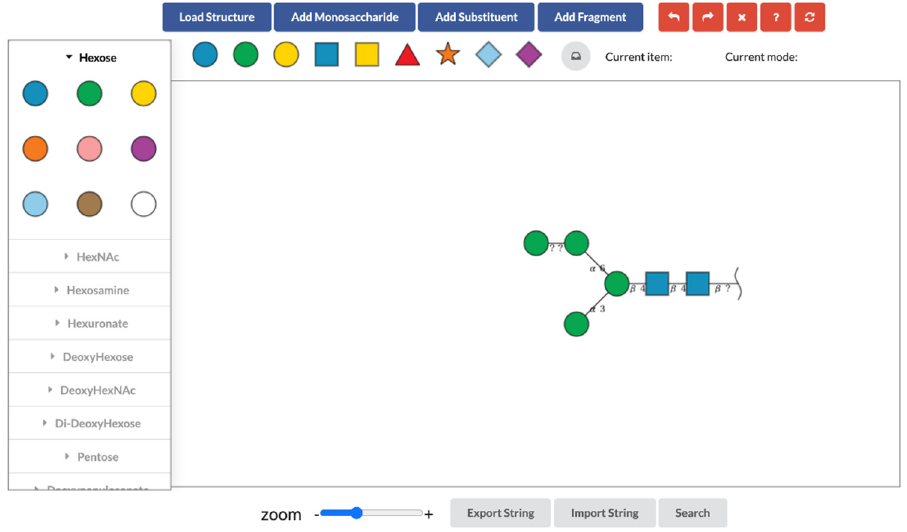
Figure 1. The interface of SugarDrawer.